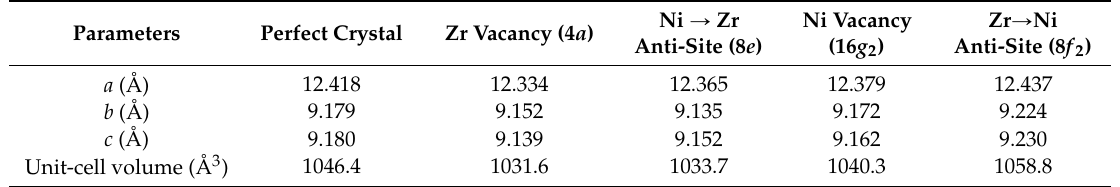
Table 3. Unit-cell lattice parameters for non-defected and defected Zr 7 Ni 10